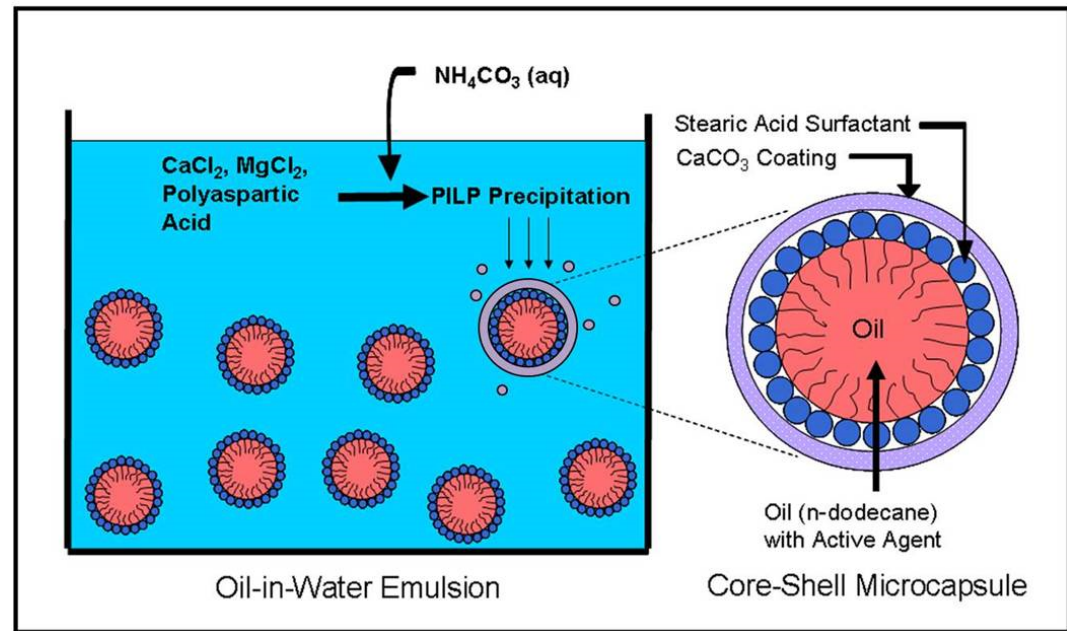
Figure 1. Schematic describing the synthesis of CaCO 3 core-shell microcapsules. Emulsion droplets or liposomes (emulsion shown above) are dispersed within an aqueous solution containing CaCl 2 , MgCl 2 , and polyaspartic acid. NH 4 CO 3 (aq) is pumped into the solution to initiate the formation of polymer-induced liquid-precursor (PILP) droplets, which then adsorb onto the charged surface of the emulsion / liposome. The liquid or gel-like character of the PILP droplets allows them to coalesce into a smooth and continuous coating, which then solidifies and crystallizes into a continuous shell of